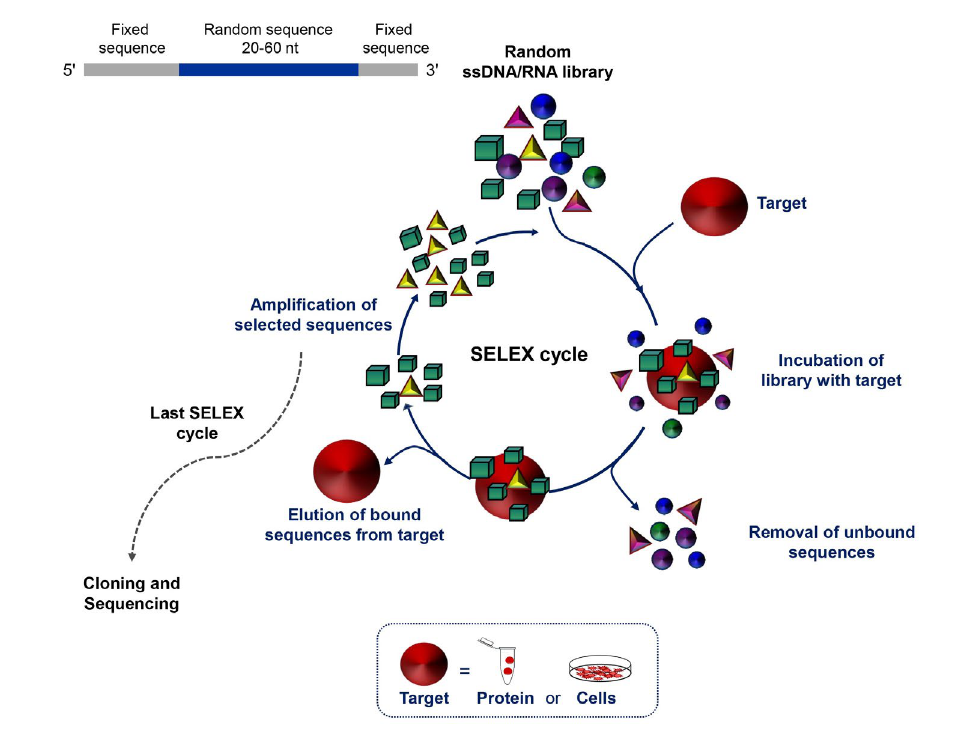
Figure 1 . Schematic representation of the SELEX technology. SELEX is a multistep process starting with random libraries of single-stranded DNA (ssDNA) or RNA flanked by two fixed primer-binding sequences on both ends necessary for enzymatic amplification and in vitro transcription (in the case of a RNA library). It includes reiterated rounds (usually 8-20) of binding, partitioning and amplification (see text for details). nt: